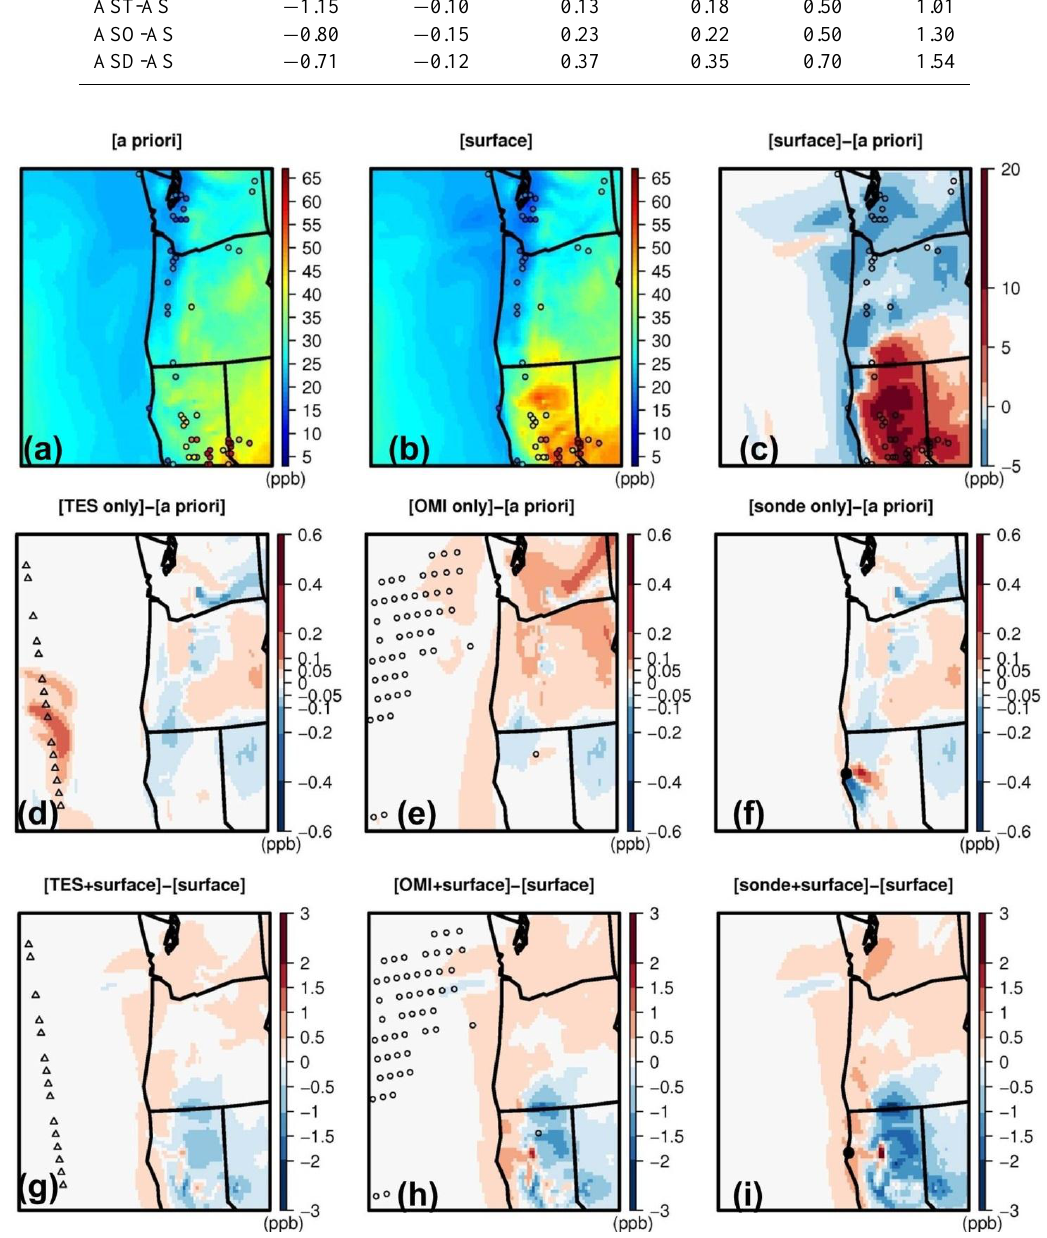
Fig. 13. Impacts of DA at the surface. Daytime-mean surface O 3 from (a) STEM a priori; and (b) Case AS. The site measurements were overlaid (only those sites that had all daytime measurements are shown in the plots). (c) Differences of (b) - (a) . Daytime-mean surface O 3 differences: (d) Case AT-STEM a priori; (e) Case AO-STEM a priori; (f) Case AD-STEM a priori. Daytime-mean surface O 3 differences: (g) Case AST-Case AS; (h) Case ASO-Case AS; (i) Case ASD-Case AS. See text and Table 3 for definition of the various